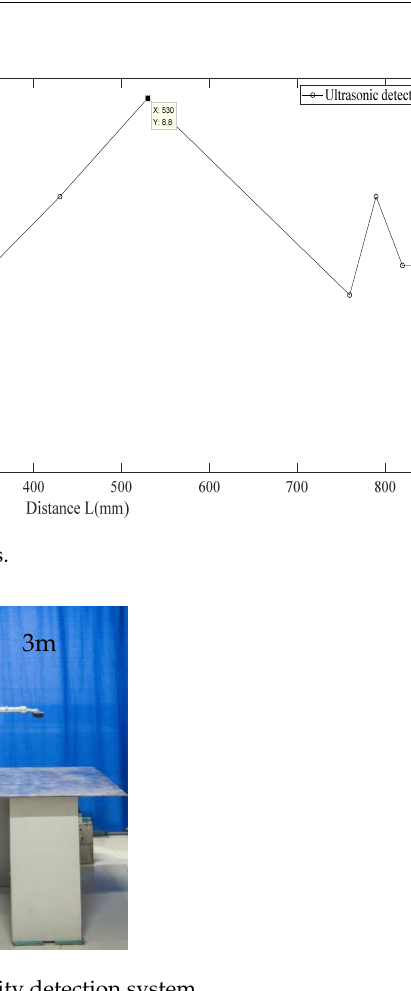
Figure 6. Three-axis magnetic intensity detection system.